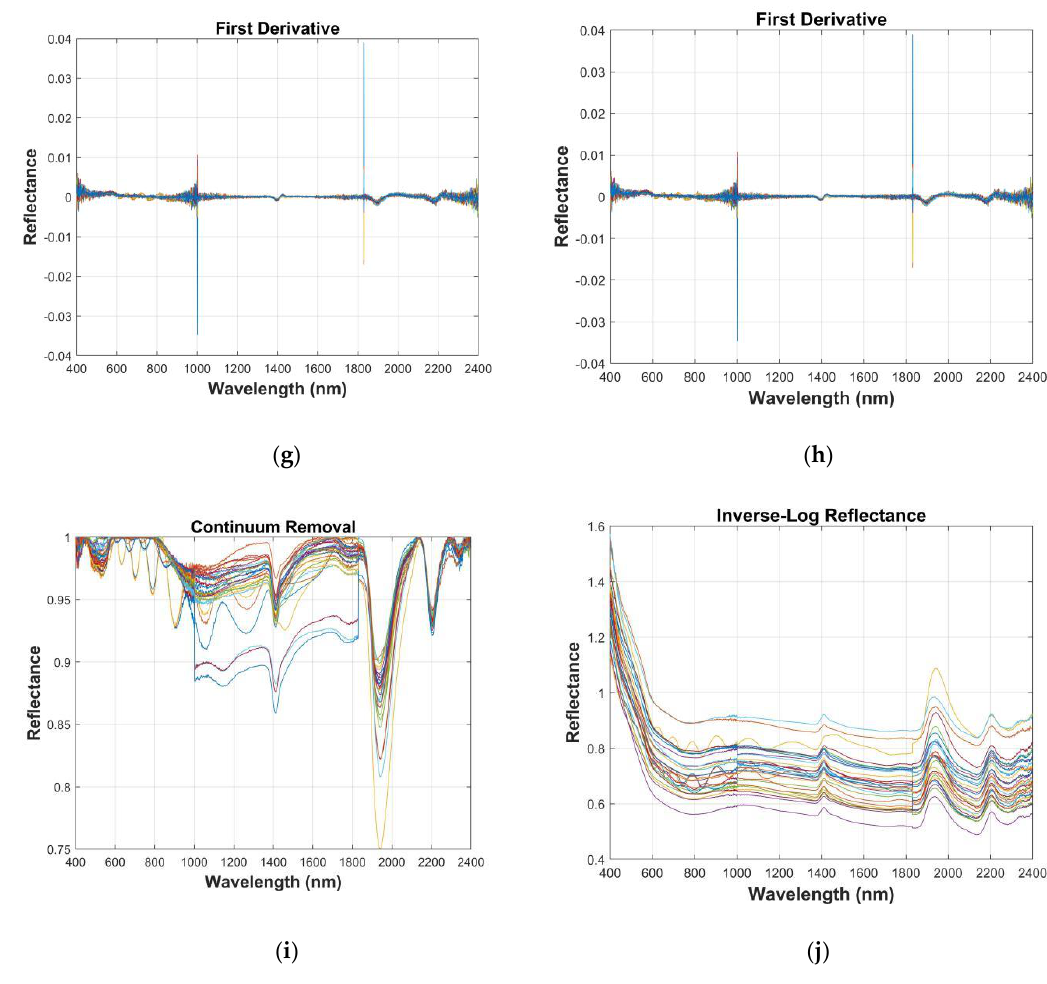
Figure 3. Soil pretreatment under different spectral indices (northwest China): ( a ) multiplicative scatter correction (MSC), ( b ) mean centering (MC), ( c ) moving average (MA), ( d ) Savitzky – Golay (SG), ( e ) first derivative after Savitzky – Golay (SG-FD), ( f ) second derivative after Savitzky – Golay (SG-SD), ( g ) first derivative (FD), ( h ) second derivative (SD), ( i ) continuum removal (CR), and ( j ) inverse-log reflectance (Log(1/R)).